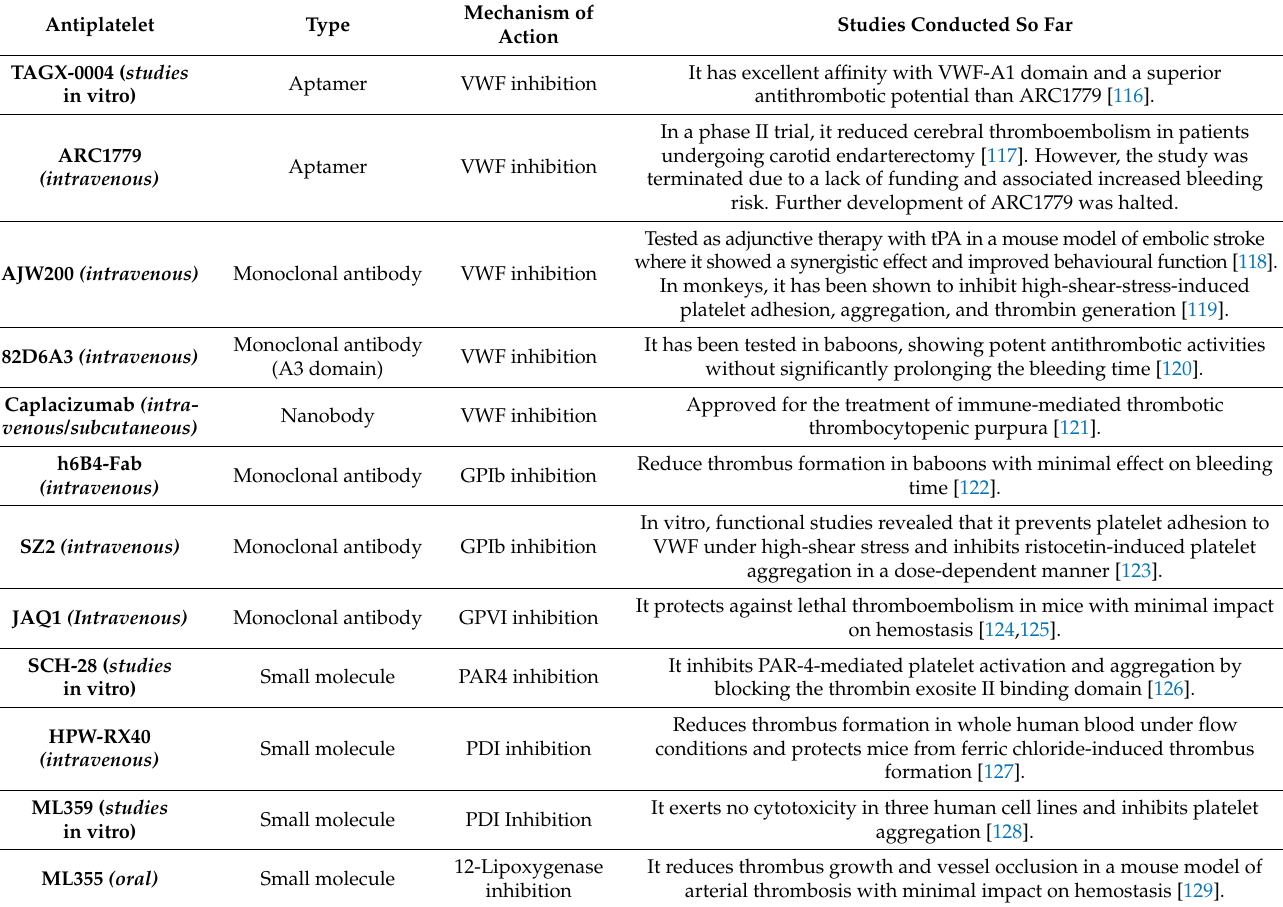
Table 5. Novel antiplatelets in the preclinical